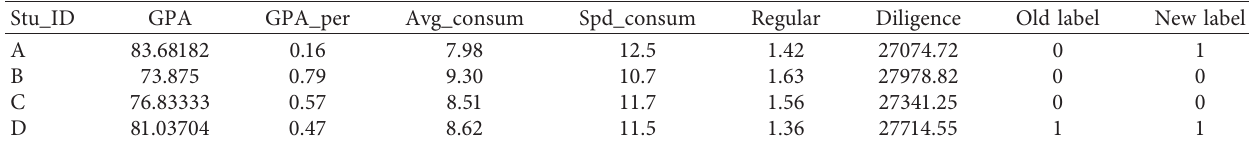
Table 17: The input format of different models with different